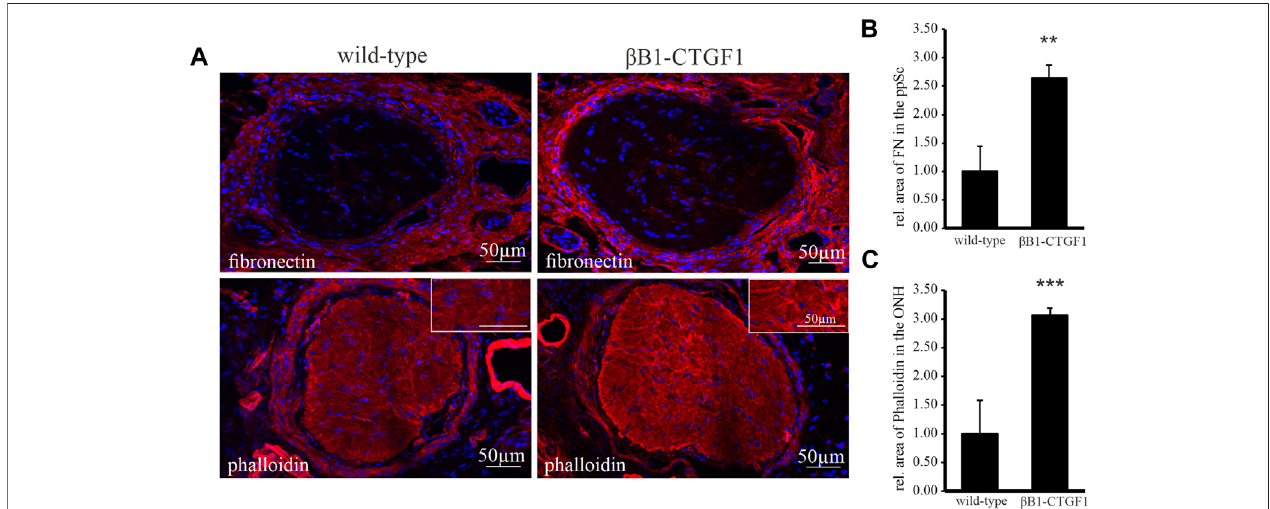
FIGURE 2 | Immunoreactivity of fi bronectin and labeling of fi lamentous actin in the ON and ONH in a murine glaucoma model. (A) Immunoreactivity of fi bronectin (red, upper panel) is increased in the peripapillary sclera of β B1-CTGF1 mice compared to WT controls. Filamentous actin labeled by Phalloidin (red, lower panel) in increased in the ONof β B1-CTGF1mice compared to WT controls. Nuclei arestained withDapi (blue). (B) Quanti fi cation ofimmunohistochemical stainingof fi bronectin show a signi fi cant increase in the peripapillary sclera of TG animals compared to controls (TG: n = 4; WT: n = 5; ** p = 0.002). (C) Quanti fi cation of immunohistochemical staining of phalloidin labeled fi lamentous actin show a signi fi cant increase in the ON of TG animals compared to controls (TG: n = 5; WT: n = 5; *** p =